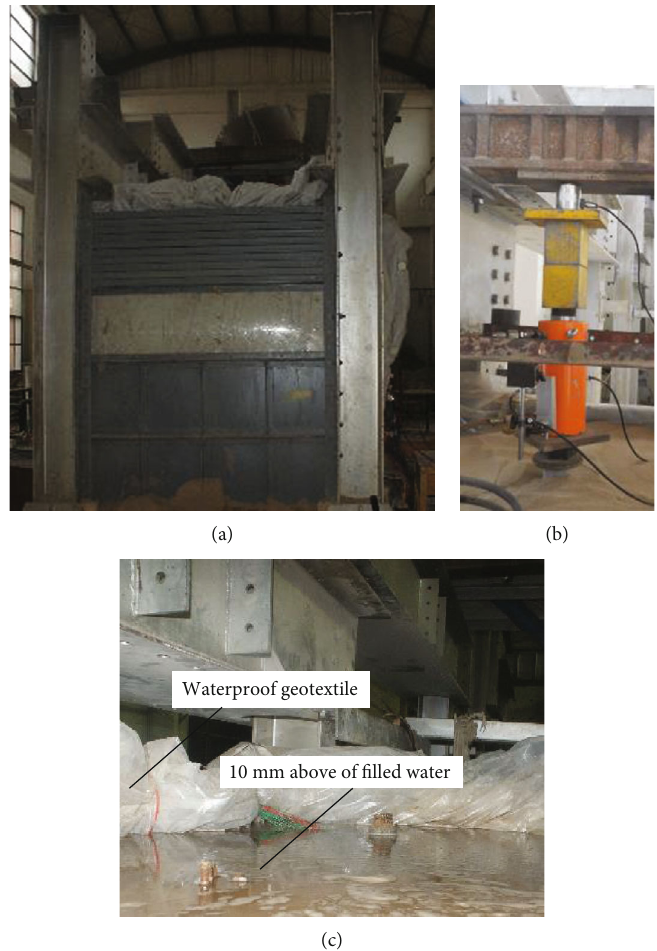
Figure 1: Physical diagram of model test system: (a) model tank; (b) hydraulic jack; (c) 10mm water above